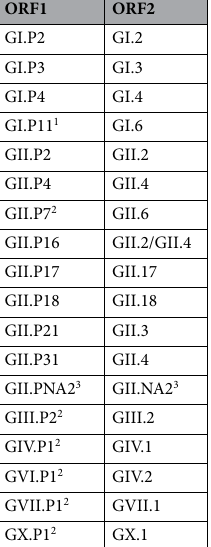
Table 2. The most common ORF1-ORF2 combinations, taken from Ref. 45 . 1 Formerly GI.Pb. 2 Only p48 was expressed. 3 Closest to